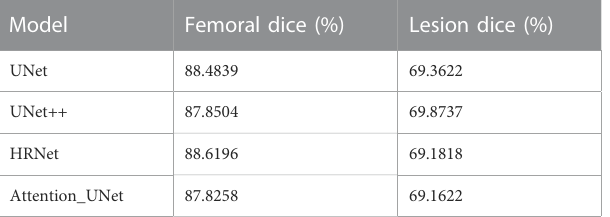
TABLE 2 Performance comparison of different backbone networks. Four different networks were assessed (UNet, UNet++, Attention-UNet, and HRNet). Model